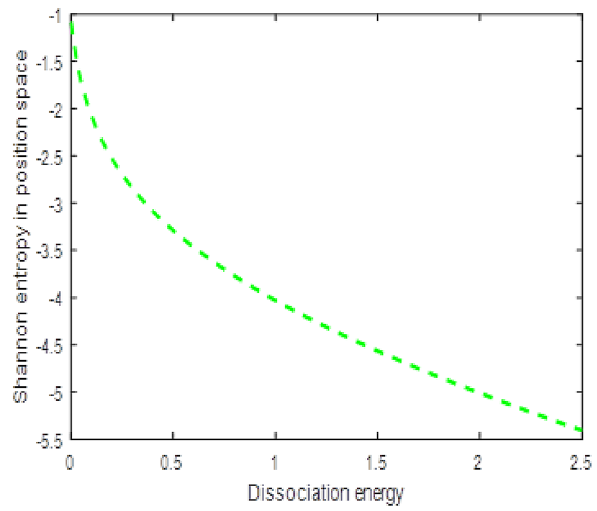
Figure 10. Shannon entropy for position space against the dissociation energy with µ = n = ℓ = (cid:31) = C = (cid:31) = 1 and r e = 0.2 of the multiple potential function.